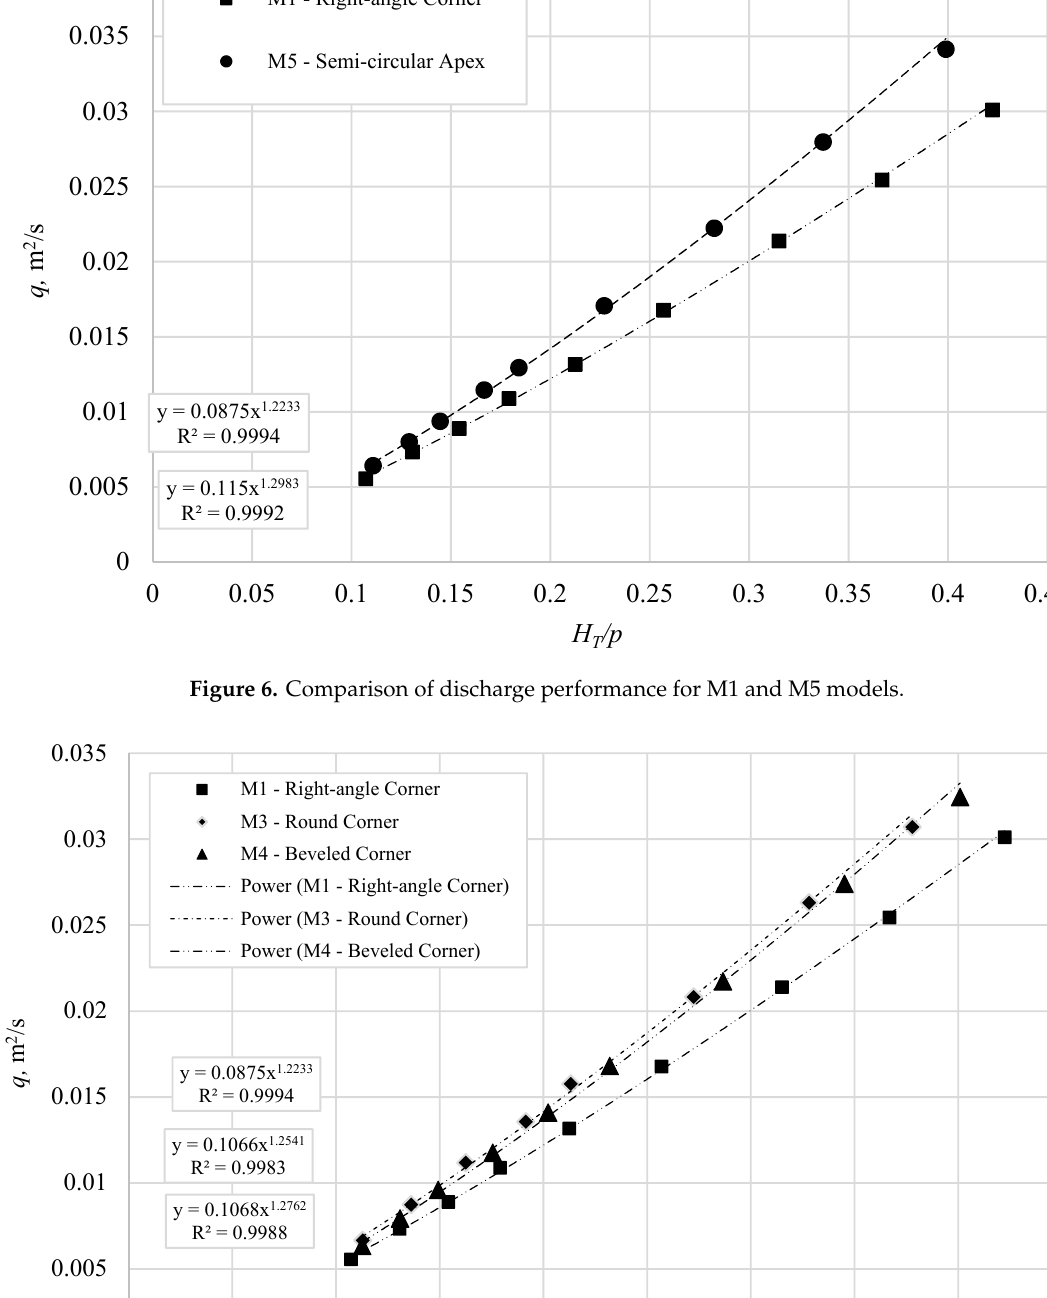
Figure 5. Variation of discharge capacity ( q ) versus H T / P for all physical models.